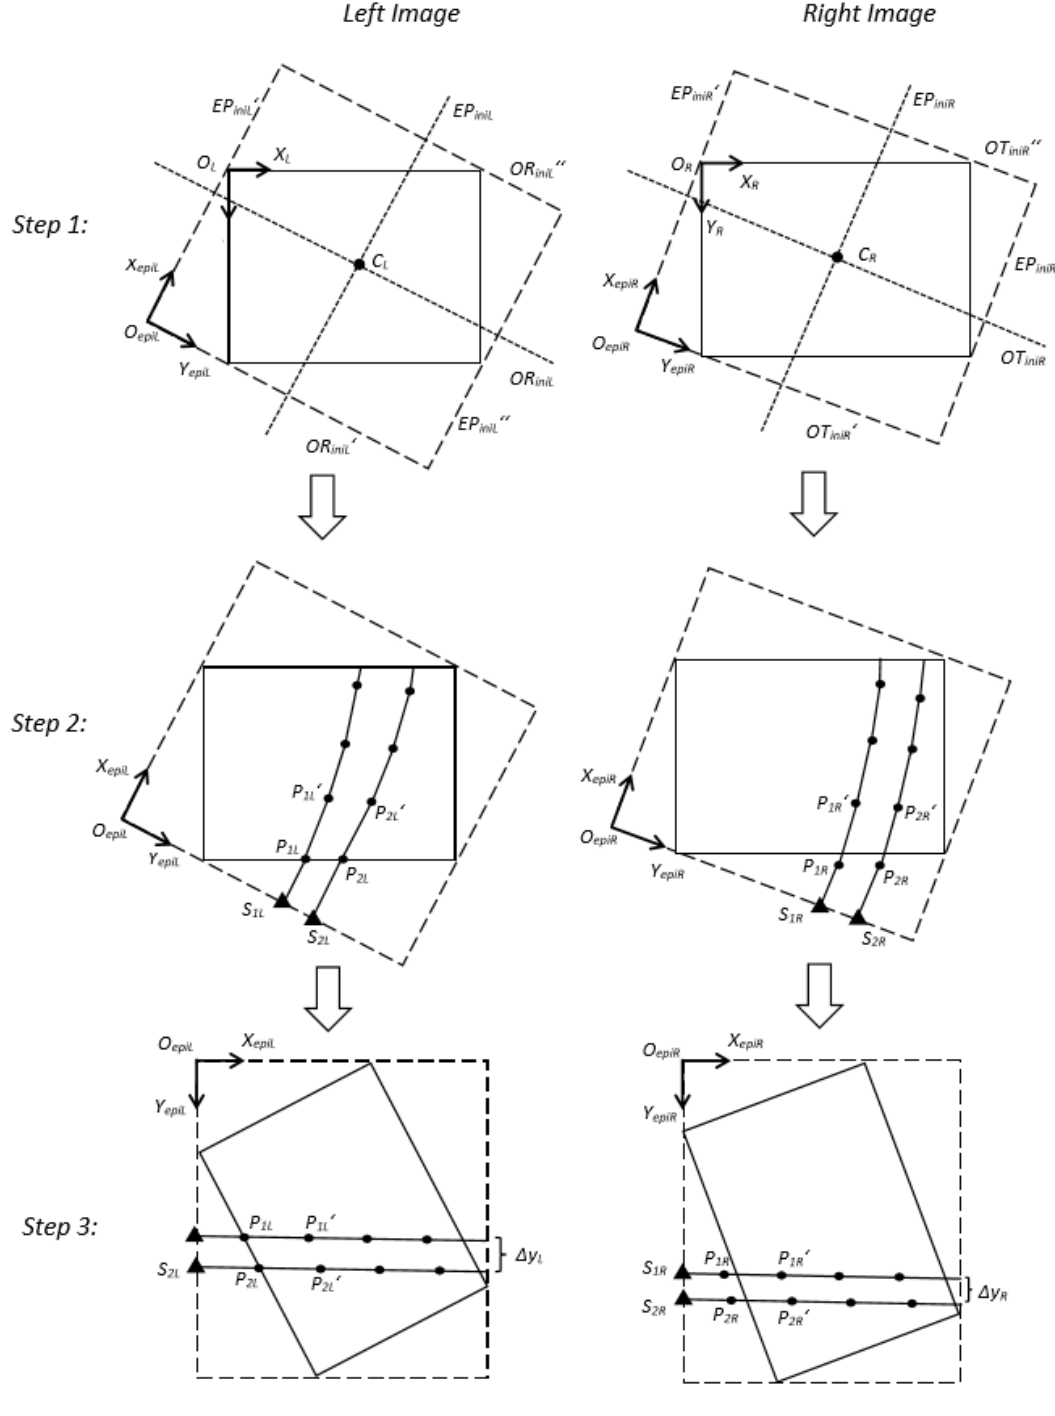
Figure 3. Modified piecewise epipolar resampling